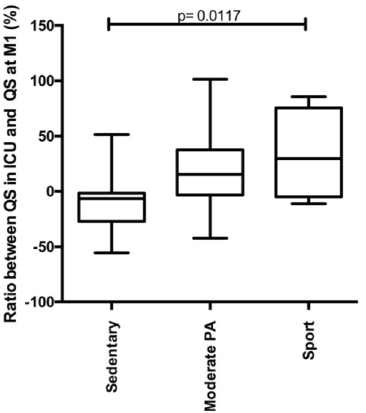
Fig. 1 QS change at M1 in CI patients according to previous physical